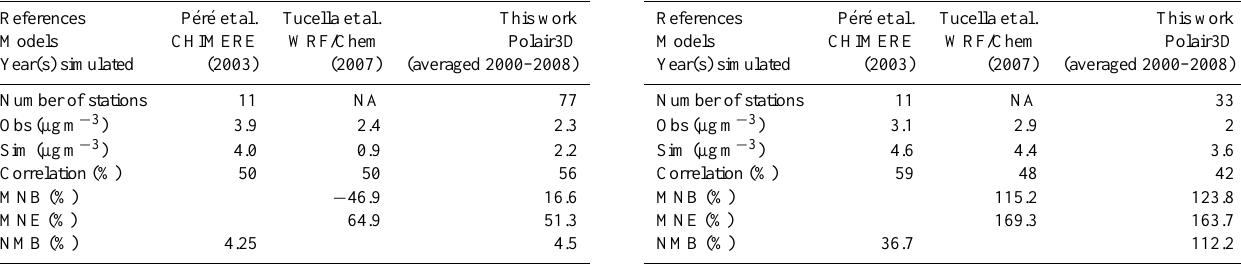
Table B2. Comparison for sulfate with P´er´e et al. (2010) and Tuc- cella et al. (2012). The data from this work are averaged over 2000– 2008.